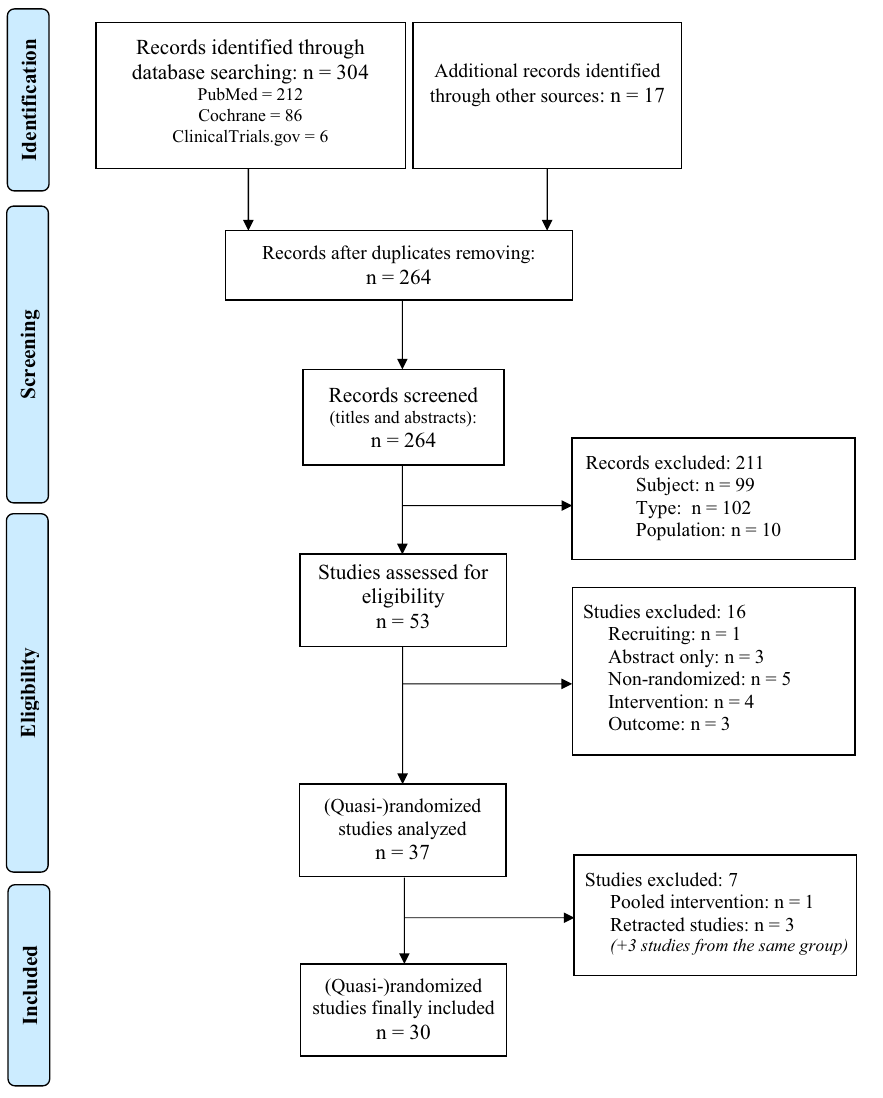
Figure 1. Flow diagram of study